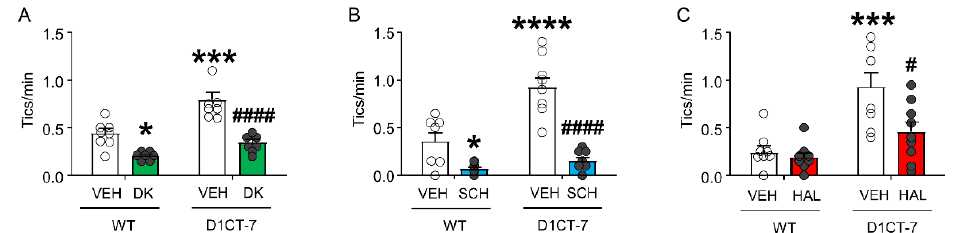
Figure 5. Effects of DK-I-56-1 (DK, 10 mg/kg, IP) on tic-like responses in D1CT-7 and wild-type (WT) mice exposed to spatial confinement, as compared with dopaminergic antagonists. ( A ) DK significantly reduced tic-like behaviors in both genotypes (Genotype × treatment interaction: F(1,25) = 4.46; p = 0.04). ( B ) The D 1 receptor antagonist SCH 23390 (SCH, 0.5 mg/kg, IP) also reduced tic-like behaviors in all genotypes (Genotype × treatment interaction: F(1,32) = 11.54; p = 0.002). ( C ) The D 2 receptor antagonist haloperidol had similar effects (HAL, 0.5 mg/kg, IP) (Genotype × treatment interaction: F(1,30) = 4.61, p = 0.04). All analyses were performed by two-way ANOVAs. * p < 0.05; *** p < 0.001; **** p < 0.0001 vs. WT mice treated with vehicle (VEH); # p < 0.05; #### p < 0.0001 vs. D1CT-7 mice treated with VEH. n = 7–9/experimental group. For further details, see